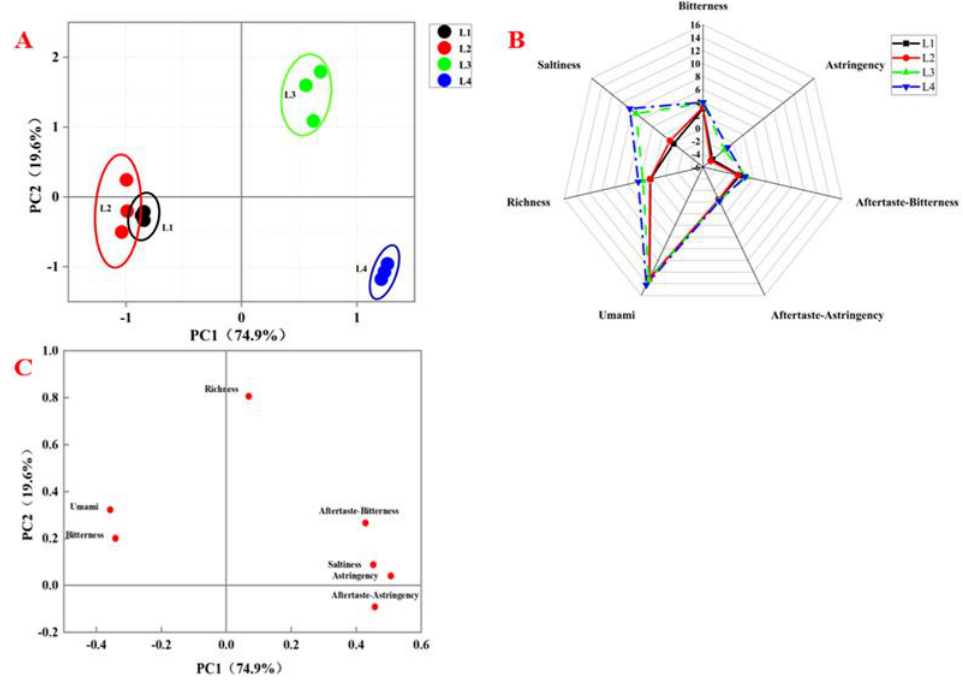
Figure 8. E-tongue analysis. ( A ) PCA plot of the samples at different processing stages. ( B ) Radar graph of the samples at different processing stages. ( C ) PCA loading plot of the samples at different processing stages.